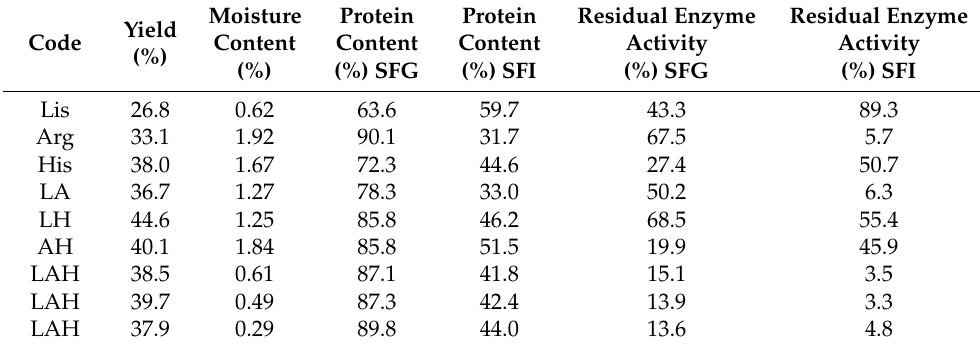
Table 2. Behavior of the developed systems in relation to the unloaded bromelain.